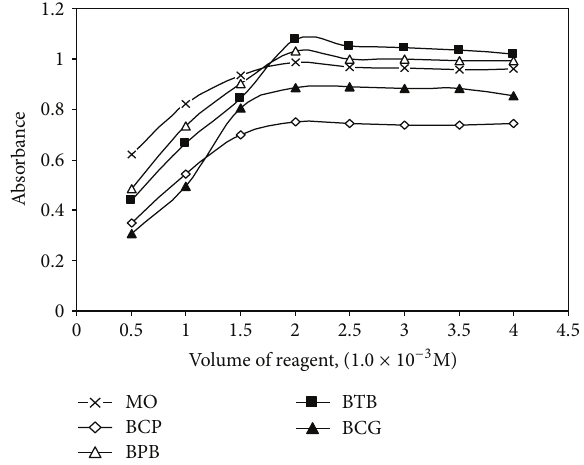
Figure 2: Effect of volume of (1.0 × 10 −3 M) reagent on the ion-pair complex formation with